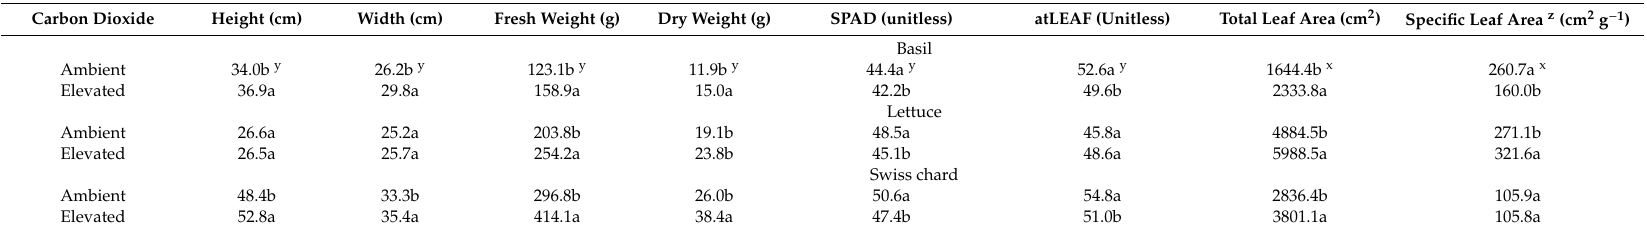
Table 1. E ff ect of CO 2 treatments (ambient at 400 ppm and supplemented at an average of 800 ppm) on height, width, fresh weight, dry weight, Soil Plant Analysis Development (SPAD), atLEAF, total leaf area, and specific leaf area values for lettuce ‘Auvona’, Swiss chard ‘Magenta Sunset’, and basil ‘Cardinal’ grown under nutrient film technique (NFT) in Stillwater, OK, USA in 2016 and 2017.